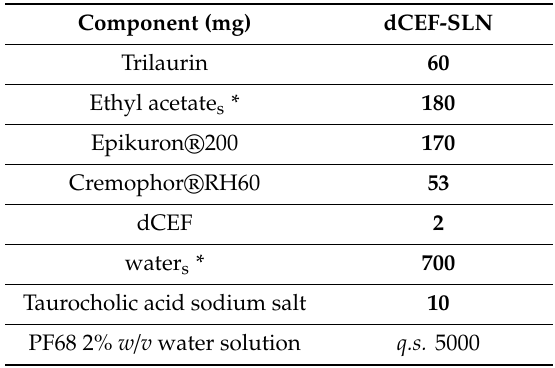
Table 2. Composition of dCEF-SLN dispersions (in bold: Composition of µ E2).